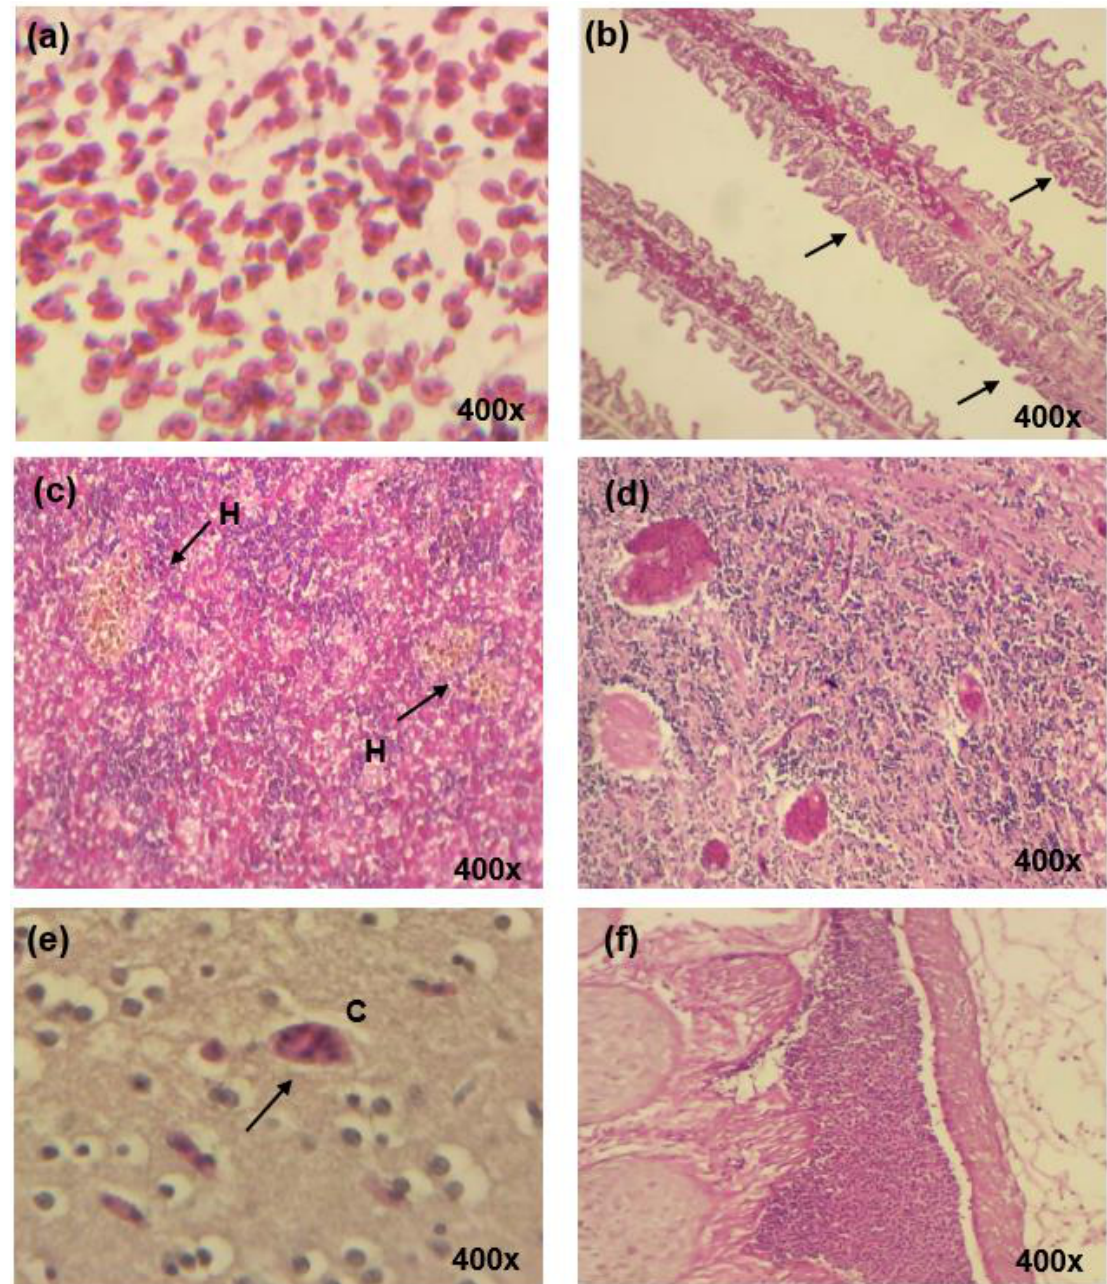
Figure 5. Histological changes in the organs of marine red hybrid tilapia after being challenged with Vibrio harveyi. ( a ) Gill from non-vaccinated fish showed hemorrhages at the connective tissue (H&E × 400); ( b ) fusion (black arrows) and detachment of secondary lamellae in non-vaccinated fish (H&E 400); ( c ) presentation of hemosiderin-phages (H) in the spleen tissue of non-vaccinated fish (H&E × 400); ( d ) brain tissue showing severe congestion in non-vaccinated fish (H&E × 400); ( e ) brain tissue from vaccinated fish showing mild congestion (C) (black arrows) (H&E × 400); ( f ) gill from a vaccinated fish showing the presence of gill-associated lymphoid tissue (GIALT) (H&E × 400).